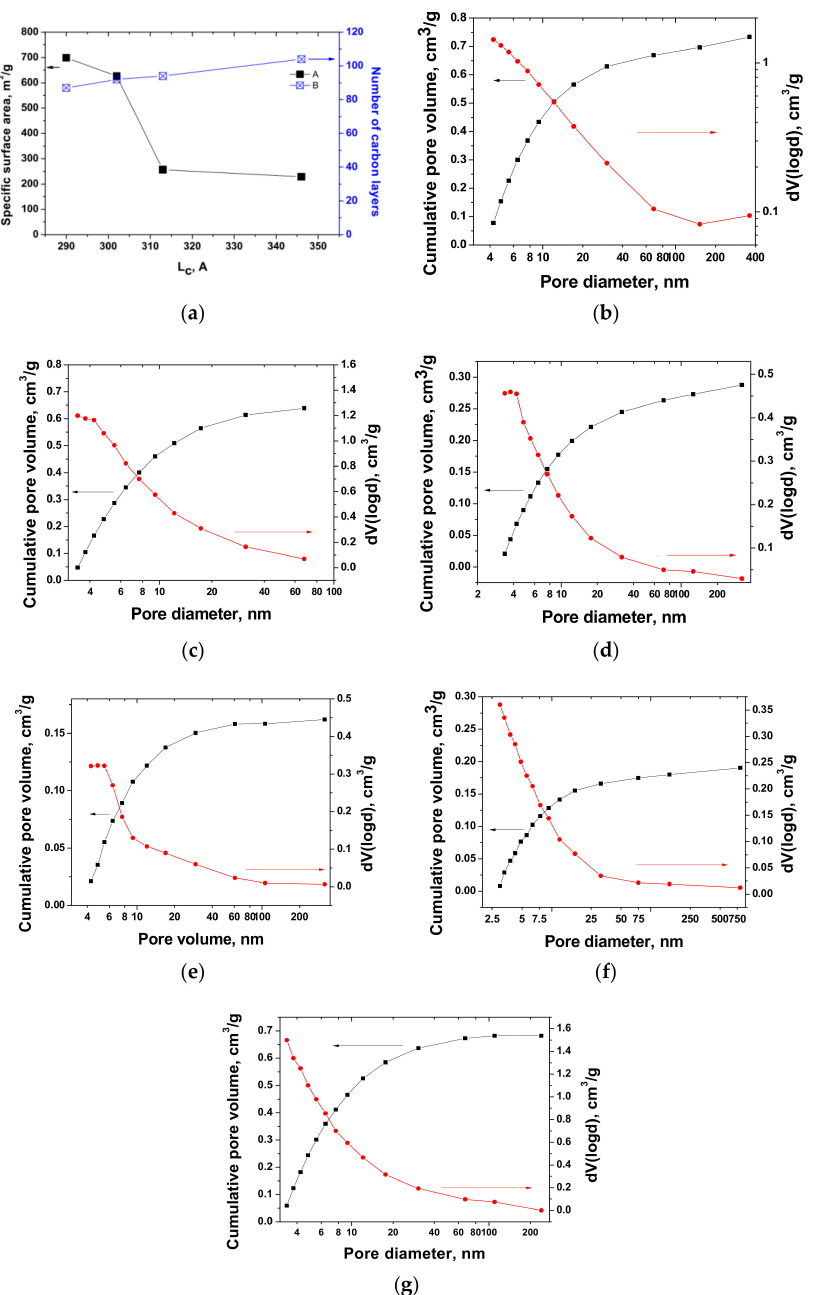
Figure 7. Link between specific surface area, number of carbon layers in crystallite and crystallite width L c . ( a ), Pore size distribution curves of EG: TEG1-400 ( b ), TEG1-500 ( c ), TEG1-600 ( d ), TEG1-700 ( e ), TEG2-400 ( f ) , TEG2-1000 ( g